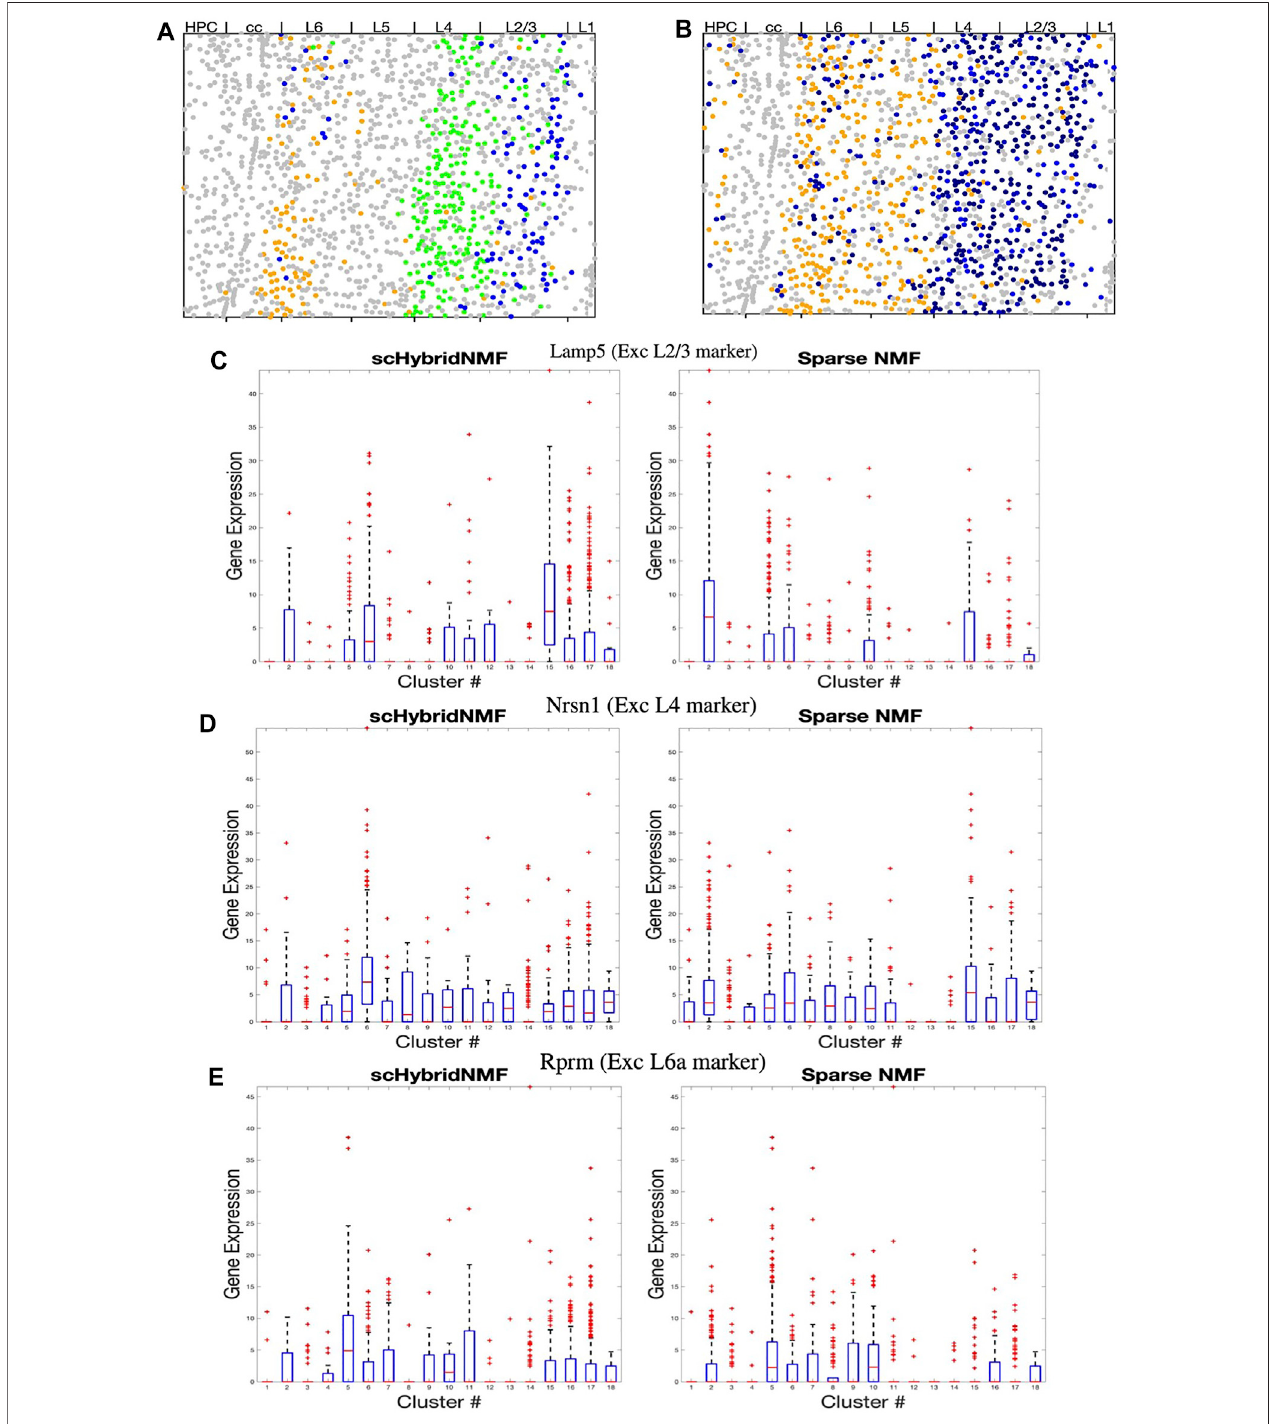
FIGURE4|(A – B) DotplotsofclustersthatbestmatchL2/3,L4,andL6aexcitatoryneurons.Allotherclustersareingrey. (A) Cluster5(L6a,orange),6(L4,green),and15(L2/3,blue) fromscHybridNMF. (B) Clusters5(L6a,orange),15(L2/3,black),and2(L2/3,black)fromsparseNMF. (C – E)